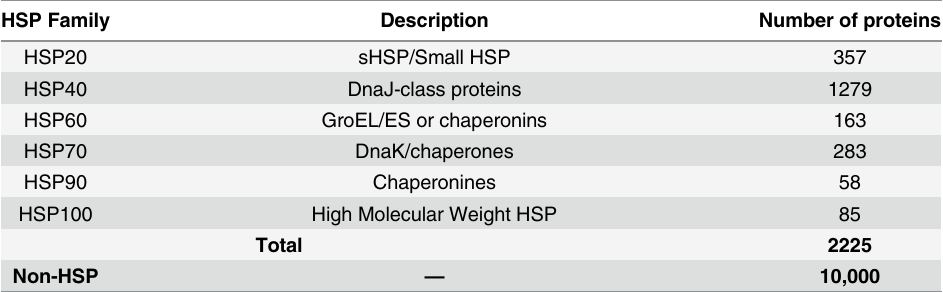
Table 1. Protein distribution in training